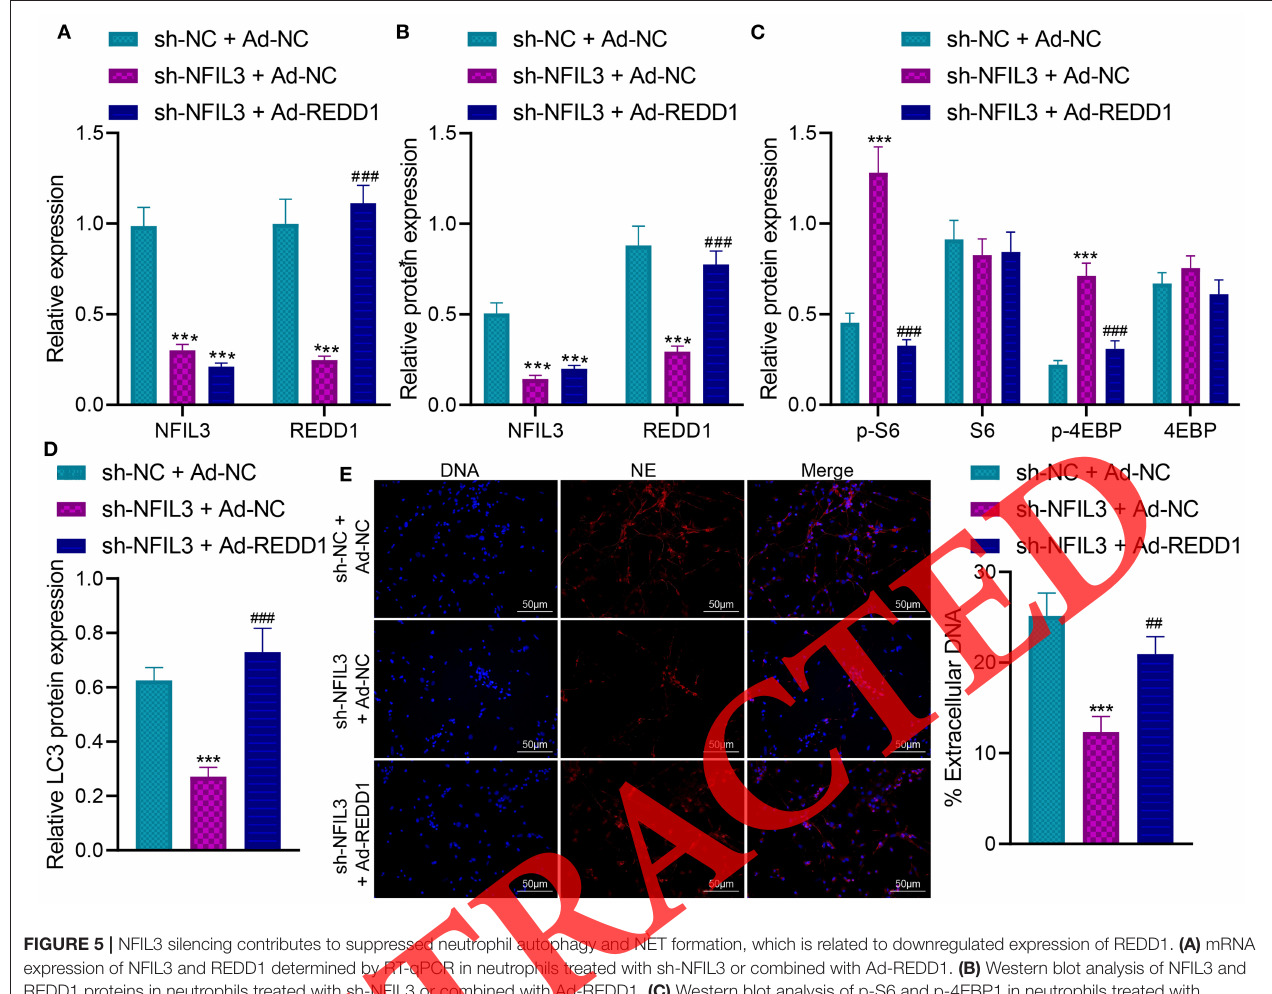
FIGURE 5 | NFIL3 silencing contributes to suppressed neutrophil autophagy and NET formation, which is related to downregulated expression of REDD1. (A) mRNA expression of NFIL3 and REDD1 determined by RT-qPCR in neutrophils treated with sh-NFIL3 or combined with Ad-REDD1. (B) Western blot analysis of NFIL3 and REDD1 proteins in neutrophils treated with sh-NFIL3 or combined with Ad-REDD1. (C) Western blot analysis of p-S6 and p-4EBP1 in neutrophils treated with sh-NFIL3 or combined with Ad-REDD1. (D) Western blot analysis of LC3 II protein in neutrophils treated with sh-NFIL3 or combined with Ad-REDD1. (E) NET formation in neutrophils treated with sh-NFIL3 or combined with Ad-REDD1, scale bar = 50 µ m. *** p < 0.001, compared to neutrophils treated with sh-NC + Ad-NC. ## p < 0.01, compared to neutrophils treated with sh-NFIL3 + Ad-NC. ### p < 0.001, compared to neutrophils treated with sh-NFIL3 + Ad-NC. Data are shown as mean ± standard deviation of three technical replicates. Data among multiple groups were assessed by one-way